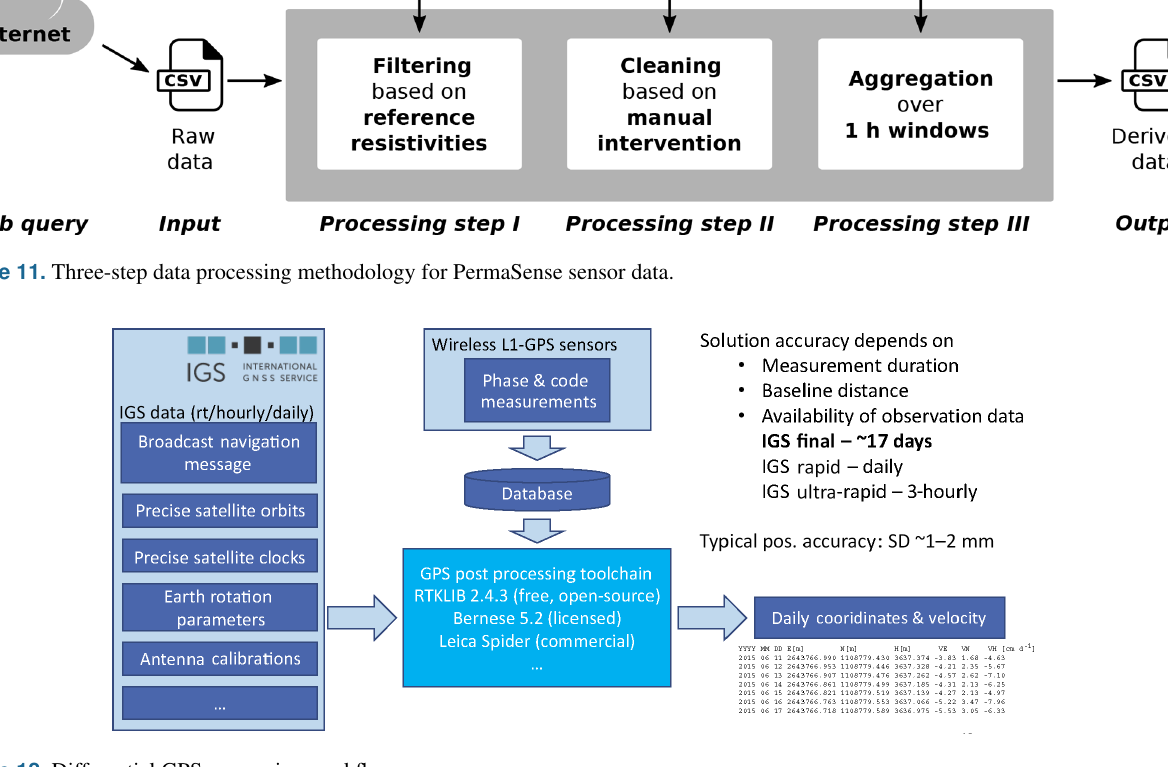
Figure 12. Differential GPS processing